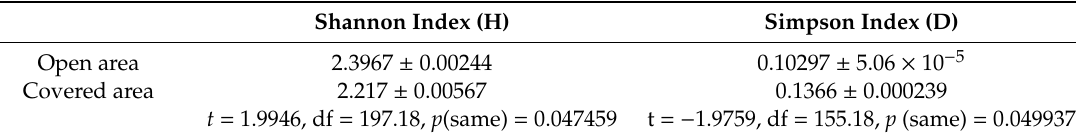
Table 10. Diversity t test of termites for the two habitats.